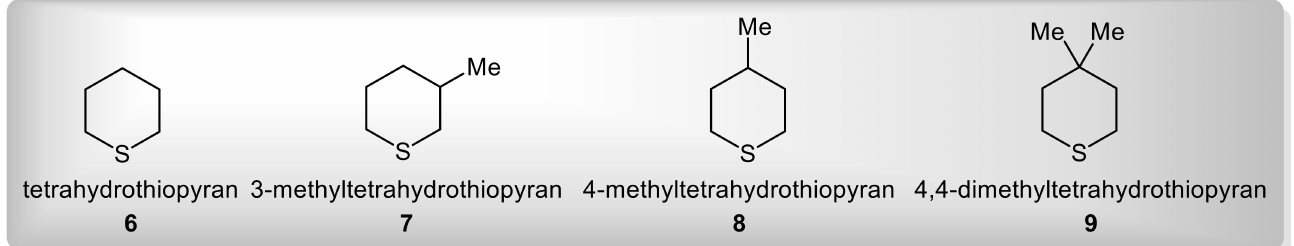
Figure 3. Structures of tetrahydrothiopyrans 6 – 9 used in the study.